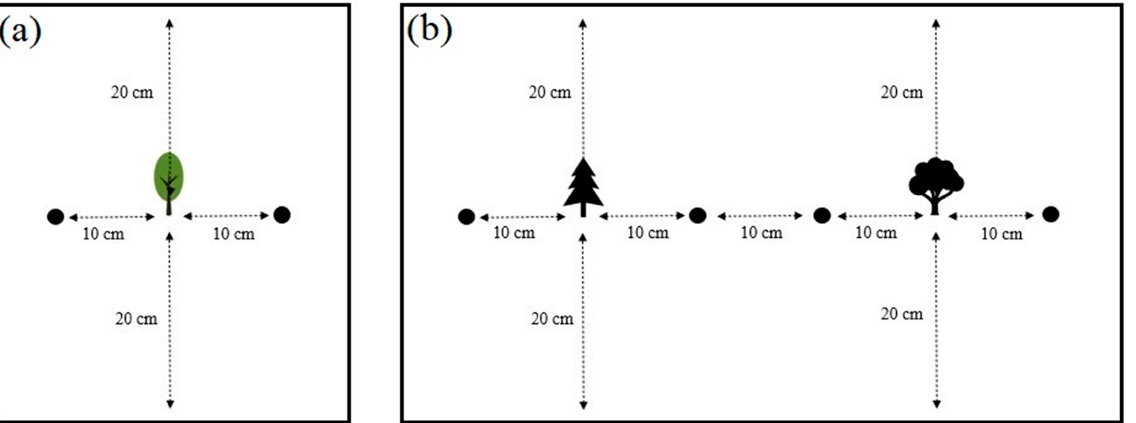
Figure 1. Planting modes and soil sampling points. ( a ) Solo planting; ( b ) mixed planting; • are the soil sampling points.